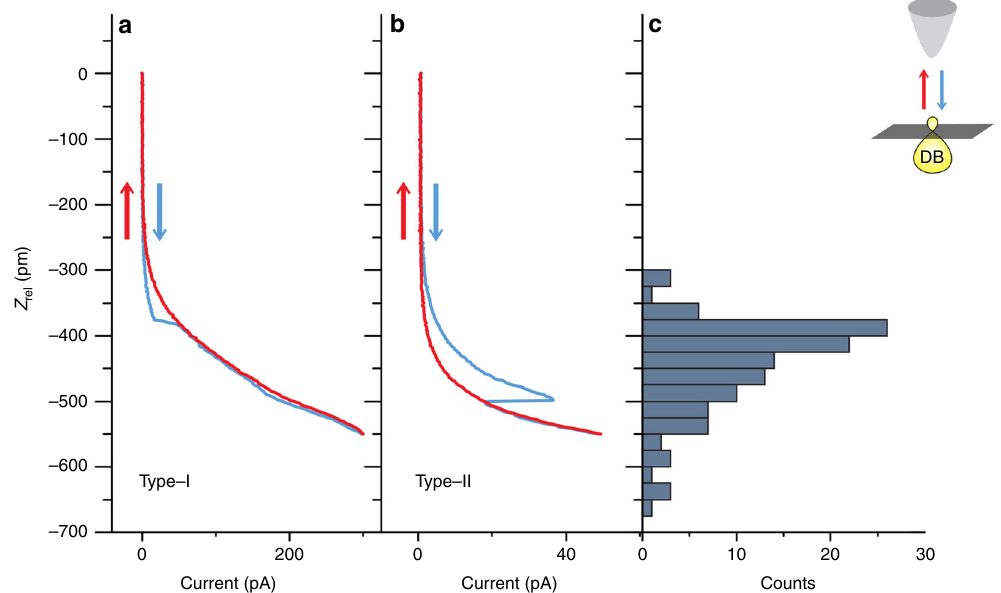
Fig. 3 Tunneling current signatures of hydrogen repassivation and the number of successful events with tip approach distance. a ( V = 0.4 V, T = 4.5 K) The recorded tunneling current as the scanning tunneling microscope (STM) tip (set over a dangling bond (DB) at 1.4 V and 50 pA) is brought towards the surface (blue) and as the STM tip is retracted (red) during hydrogen repassivation (HR). A sudden increase as the tip approaches the surface can be observed in the tunneling current (blue), indicating a successful HR event. This signature (type-I) is typically associated with a change in STM imaging resolution, and a removal of hydrogen from the tip apex. b ( V = 0.2 V) A second distinct signature (type-II) has also been observed during HR, with a sudden decrease in tunneling current during the approach towards the surface (blue). This type-II signature is not typically associated with a change in STM imaging resolution. c The tip approach distance where either signature occurred was recorded for 119 unique HR events. Nearly 90% of events occur before 550 pm. The inset depicts the STM tip approaching a DB on the